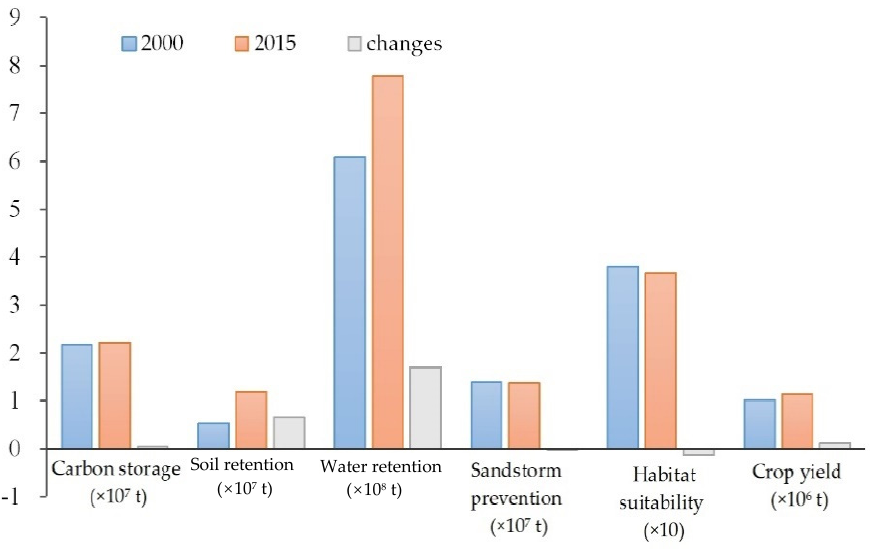
Figure 4. ESs in 2000 and 2015.